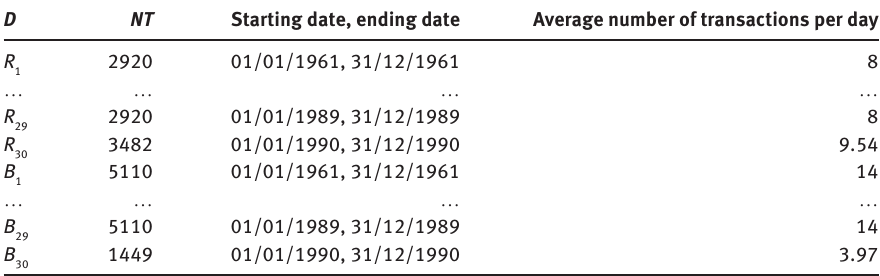
Table 5. Characteristics of Yearly Databases.